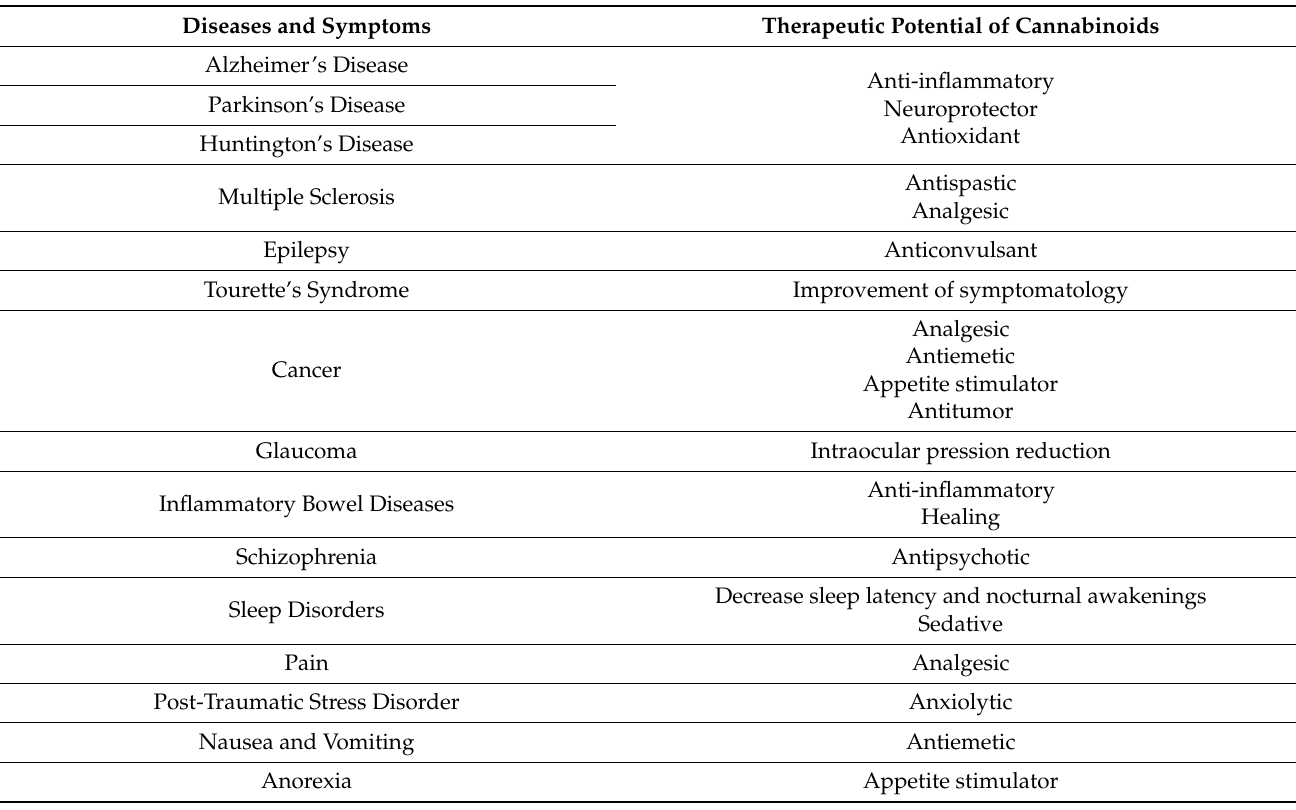
Table 1. Summary of the therapeutic potential of cannabinoids in different diseases and